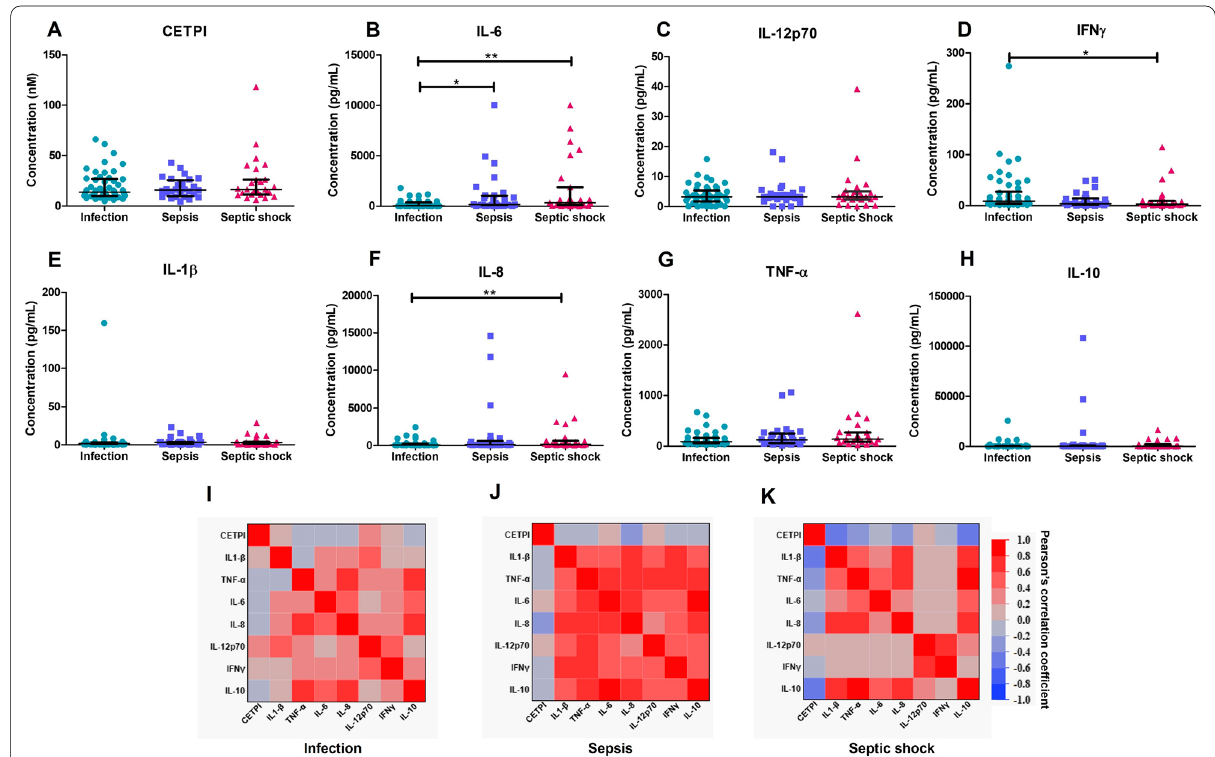
Fig. 3 CETPI and cytokines plasma levels in patients with infection, sepsis, and septic shock due to Gram‑negative bacteria. A CETPI. B Interleukin‑6 (IL‑6). C Interleukin‑12p70 (IL‑12p70). D Interferon γ (IFNγ). E Interleukin‑1 beta (IL‑1β). F Interleukin‑8 (IL‑8). G Tumor necrosis factor‑alpha (TNF‑α). H Interleukin‑10 (IL‑10). Data are shown as median with IQR; *p < 0.05, **p < 0.01; Differences between groups were assessed using Kruskal–Wallis test and subsequent Dunn’s Multiple Comparison test. I Pearson’s correlation values between the 7 cytokines and CETPI in patients with infection, J sepsis, and K septic shock. The red color indicates a positive correlation, and the blue color a negative